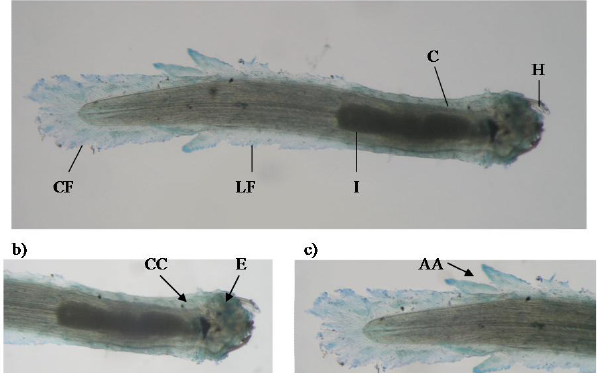
Figure 1. Paraspadella nana a) Dorsal view of (CF – caudal fin; LF – lateral fin; I – intestine; C – collarette; H – hooks), b) Head and trunk